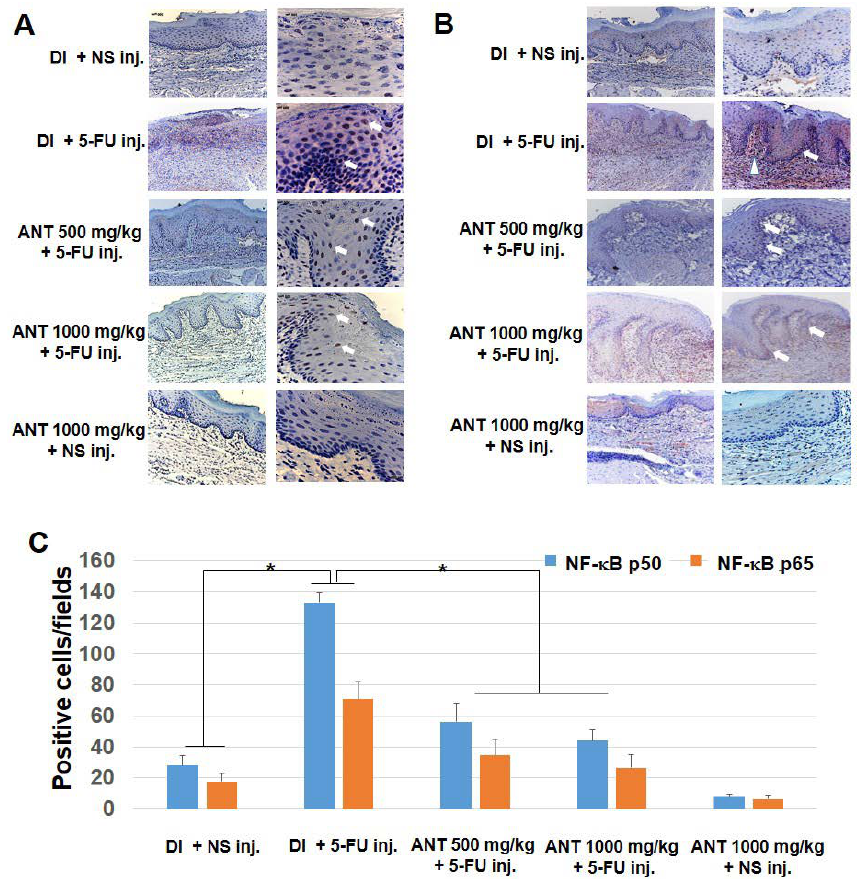
Figure 5. Localization of NF- κ B p50 and p65 isoform in oral mucositis. By immunohistochemistry, slides were stained with ( A ) anti-NF- κ B p50 Ab; ( B ) anti-NF- κ B p65 Ab. Nuclei were counterstained with Mayer’s hematoxylin. Arrows indicate positive stained nuclei in oral epithelial cells. The arrowhead indicates inflammatory cells. Original magnification × 10 (left images) and × 40 (right images); ( C ) the number of NF- κ B-positive cells per field. Data are expressed as the mean ± S.D. Error bars indicate standard deviation ( n = 6), * p < 0.001.